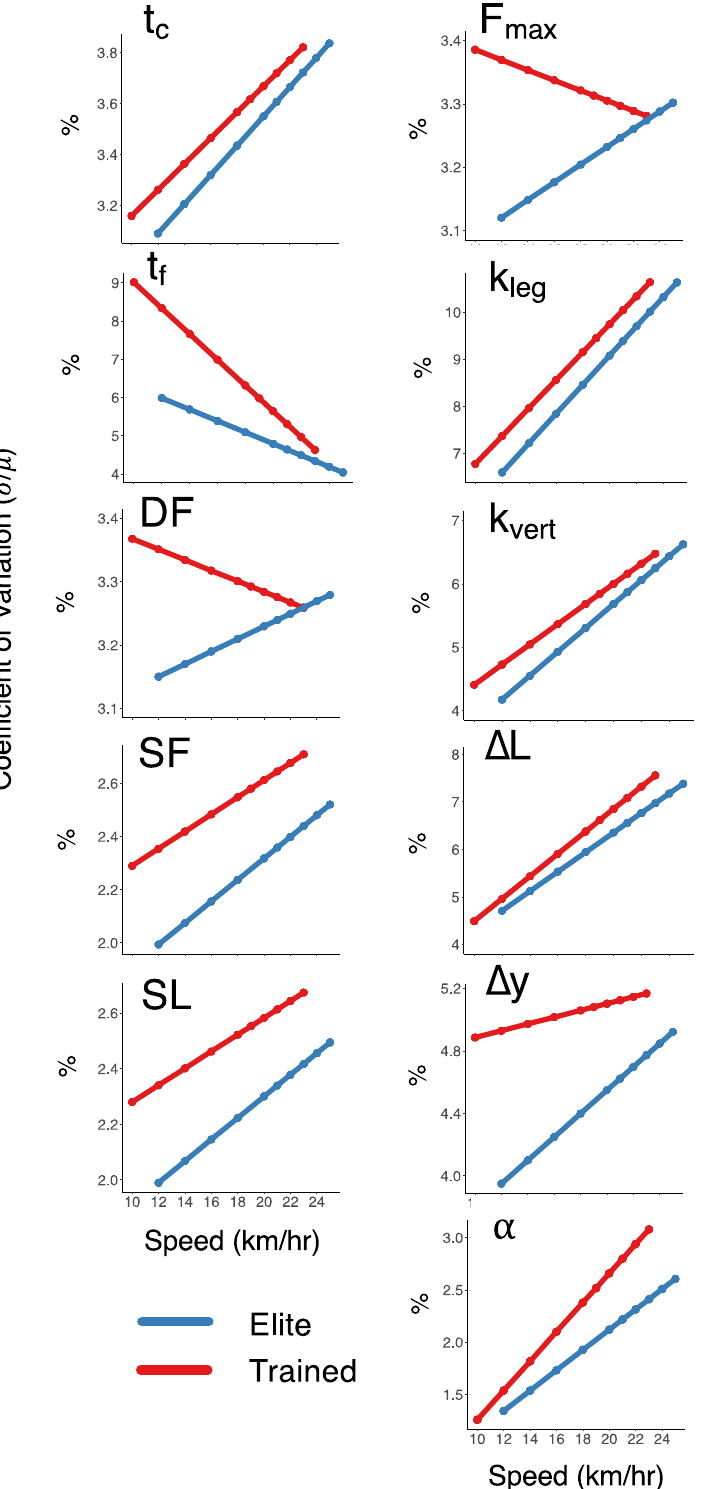
Figure 4. Coefficient of variations at each speed for the spatiotemporal and spring-mass characteristics of the elite and trained